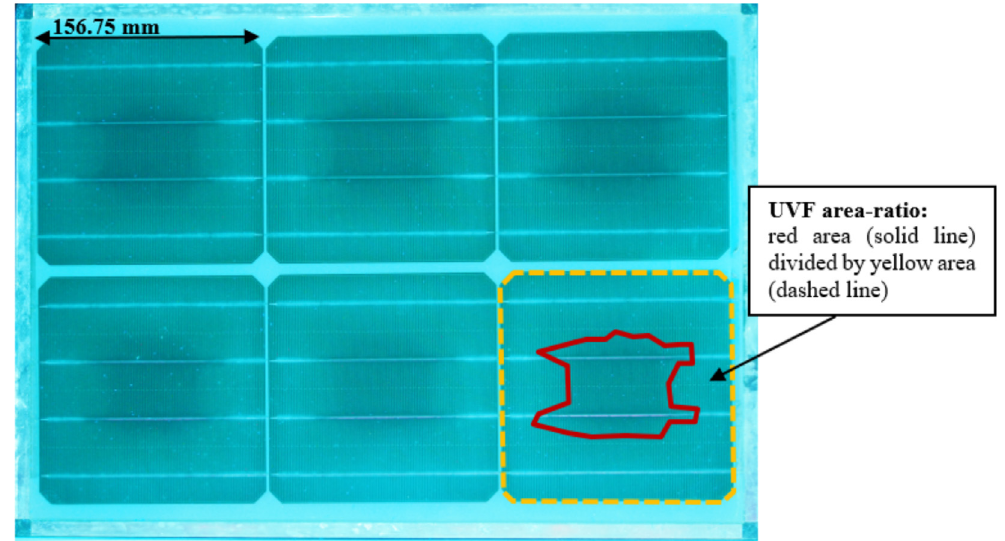
Fig. 1. Typical UVF pattern after 6000 h of (accelerated) aging (Tropical